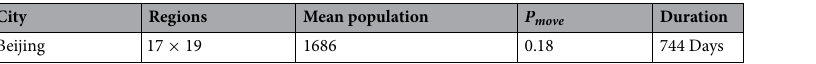
Table 4. The summary of the prolonged dataset. P move counts the mean probability for an individual to move in 1